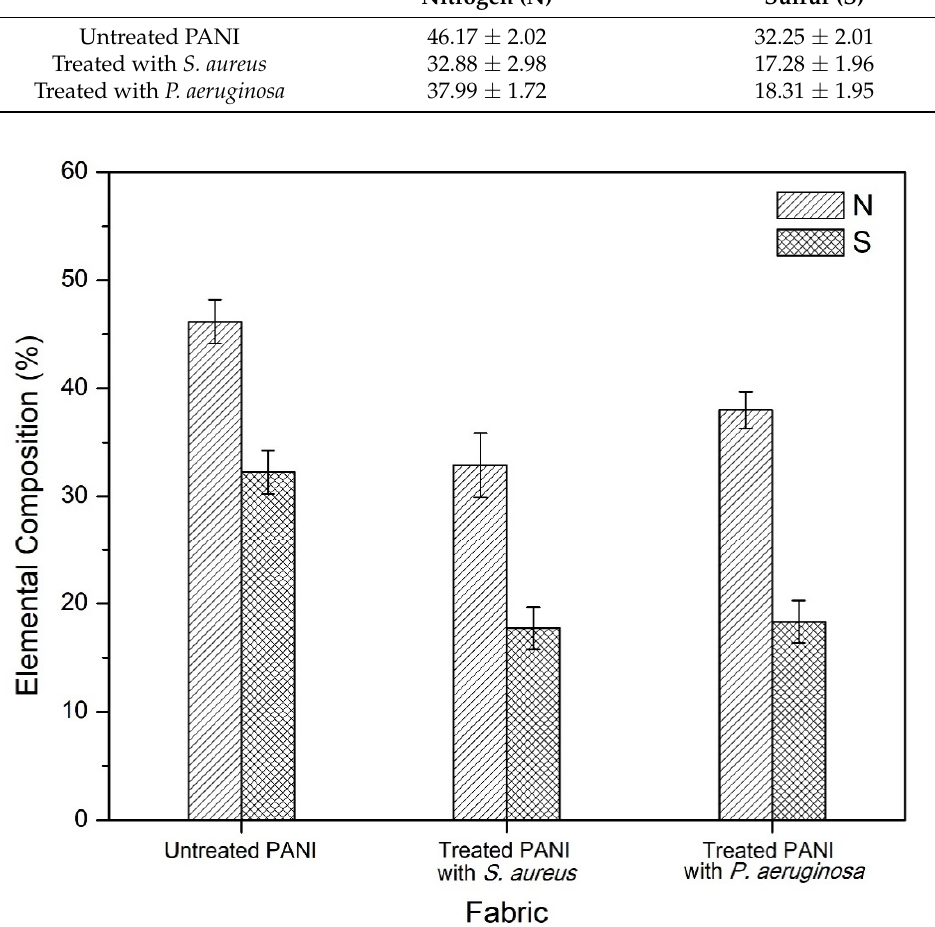
Figure 8. Elemental compositions of untreated PANI fabric, and of PANI fabric treated with S. aureus and P. aeruginosa .